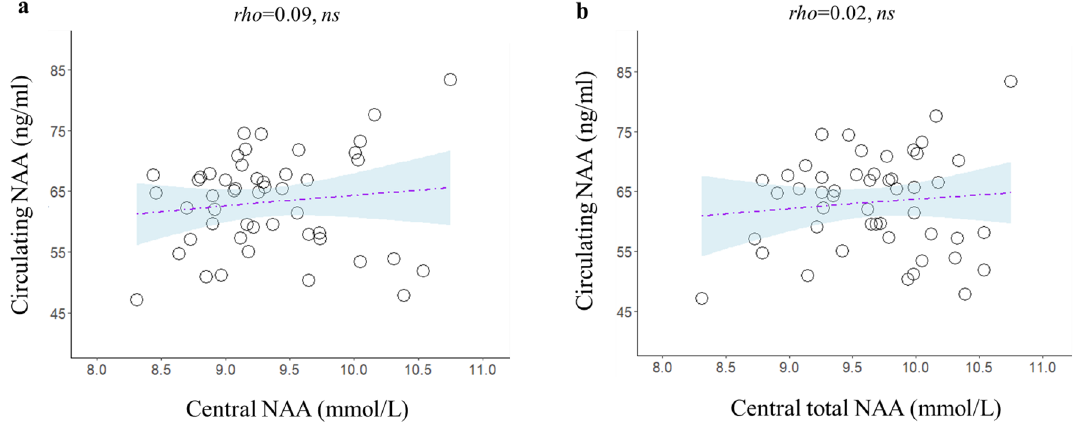
Figure 2. Relationship between brain NAA ( a ) and brain total NAA ( b ) and circulating NAA